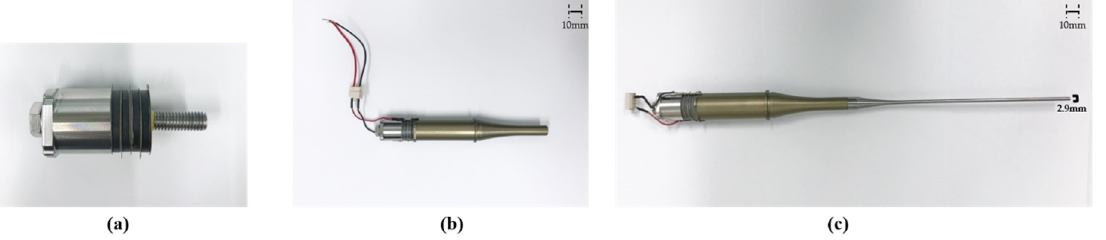
Figure 3. Transducer assembly: ( a ) back mass and piezoelectric layer clamped by a central bolt; ( b ) transducer without acoustic rod; ( c ) complete transducer set.